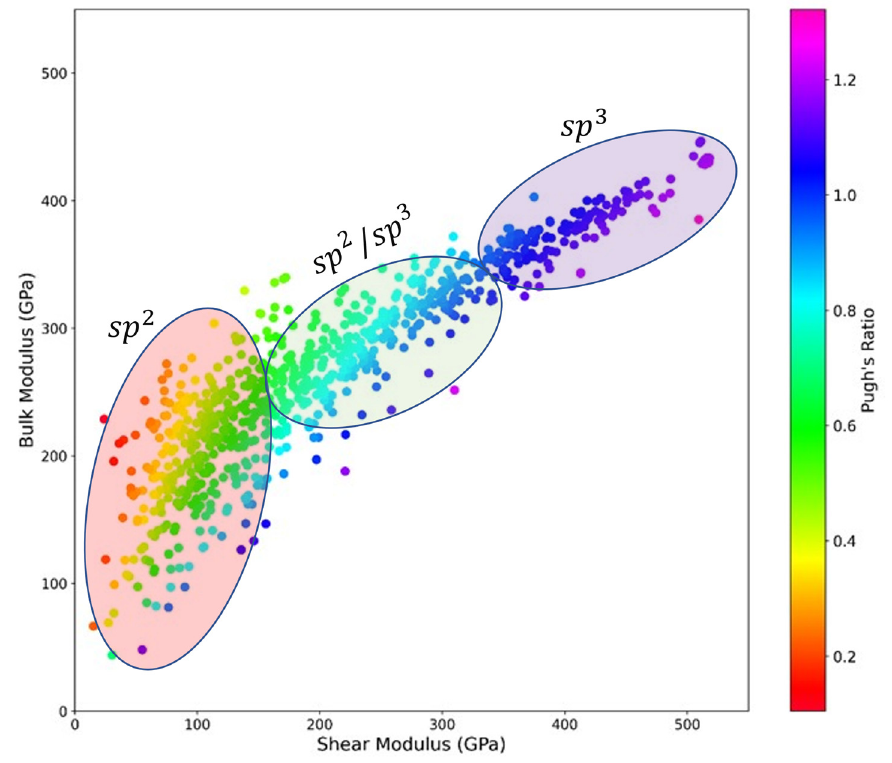
Figure 4. 2D map of bulk modulus vs. shear modulus, with Pugh’s ratio as color bar to explain hardness and show the relationship between all the mentioned properties.